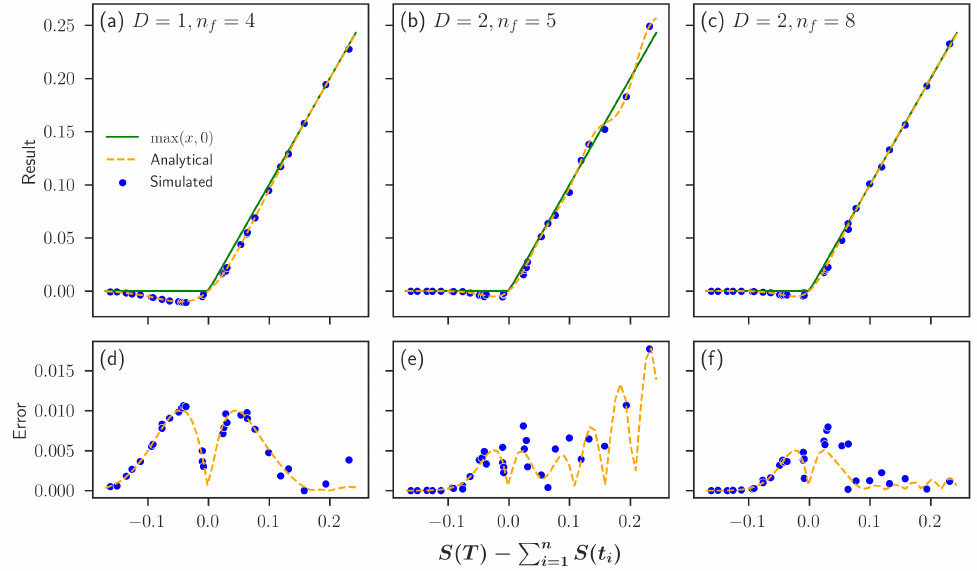
Figure 5. Comparison of different approximation levels D and terms in the Fourier series n f when evaluating an Asian option on a quantum computer simulator for different paths of the underlying valuation tree. In ( a – c ), we compare the circuit result (blue) for 10 7 executions to the analytical value (orange) we expect, and we try to approximate the option payoff (green). In ( d – f ), we present the respective absolute errors of the circuit and analytical results to the option